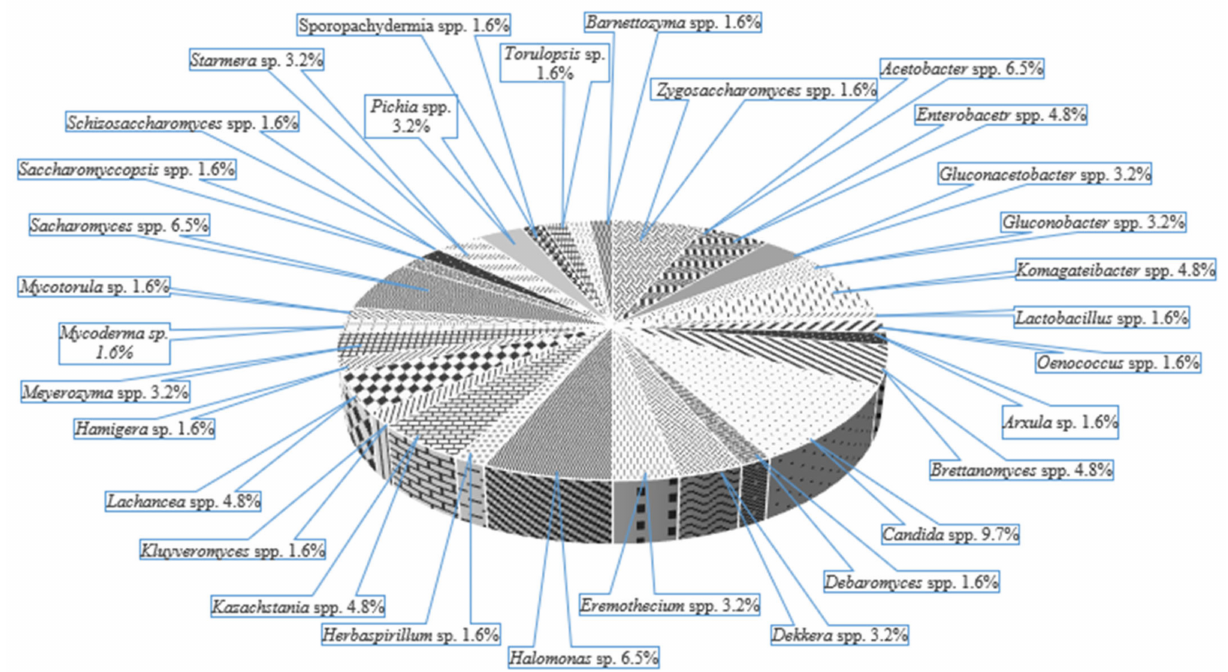
Figure 7. The microorganisms’ diversity in Kombucha (adapted from Soares et al.